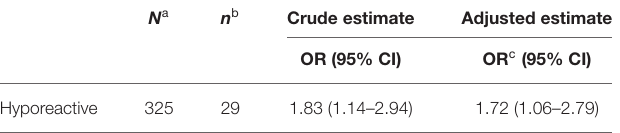
TABLE 8 | Odds ratio (OR) and 95% confidence intervals (CI) of the association between attempted suicide at follow-up and hyporeactivity. N a n b